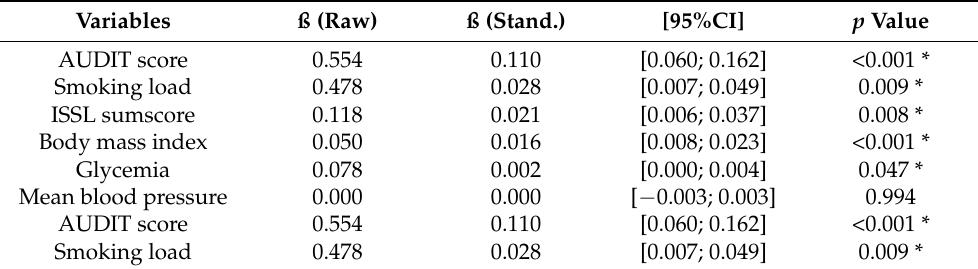
Table 2. Generalized linear models comparing the adjusted effect size of each cardiovascular risk fac- tor (independent variables) on the total number of risk factors (dependent variable) after adjustment by age and